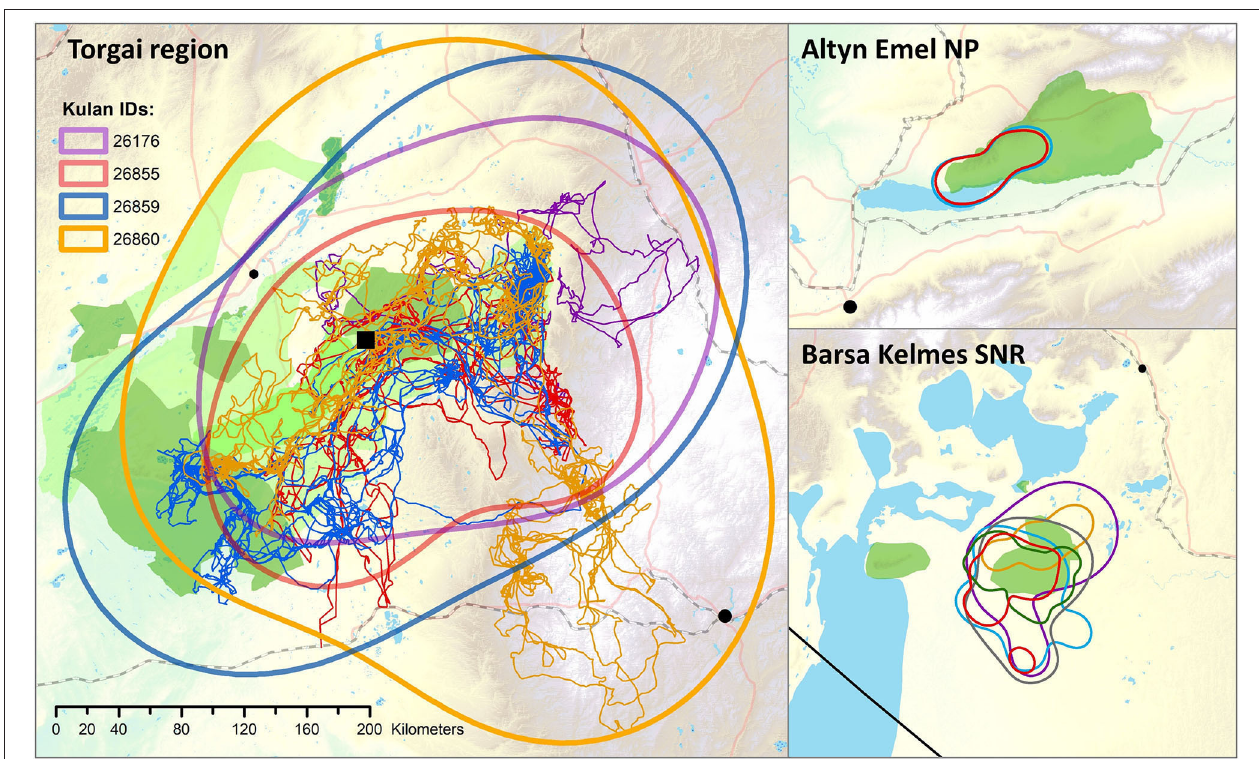
FIGURE 6 | Movement paths and 95% Autocorrelated Kernel Density Estimates (AKDE) of reintroduced kulan in the Torgai region (April 2018 to July 2020). The smaller panels show the 95% ADKEs of kulan in the source populations in Altyn Emel National Park (NP; October 2017–01.12.2020) and Barsa Kelmes State Nature Reserve (SNR; April 2019–01.12.2020). All maps are on the same scale and share the scalebar for the Torgai region. For an overview of the study areas and the legend of landscape features see Figure 1 . The black line at the south-western corner in Barsa Kelmes is the international border between Kazakhstan and